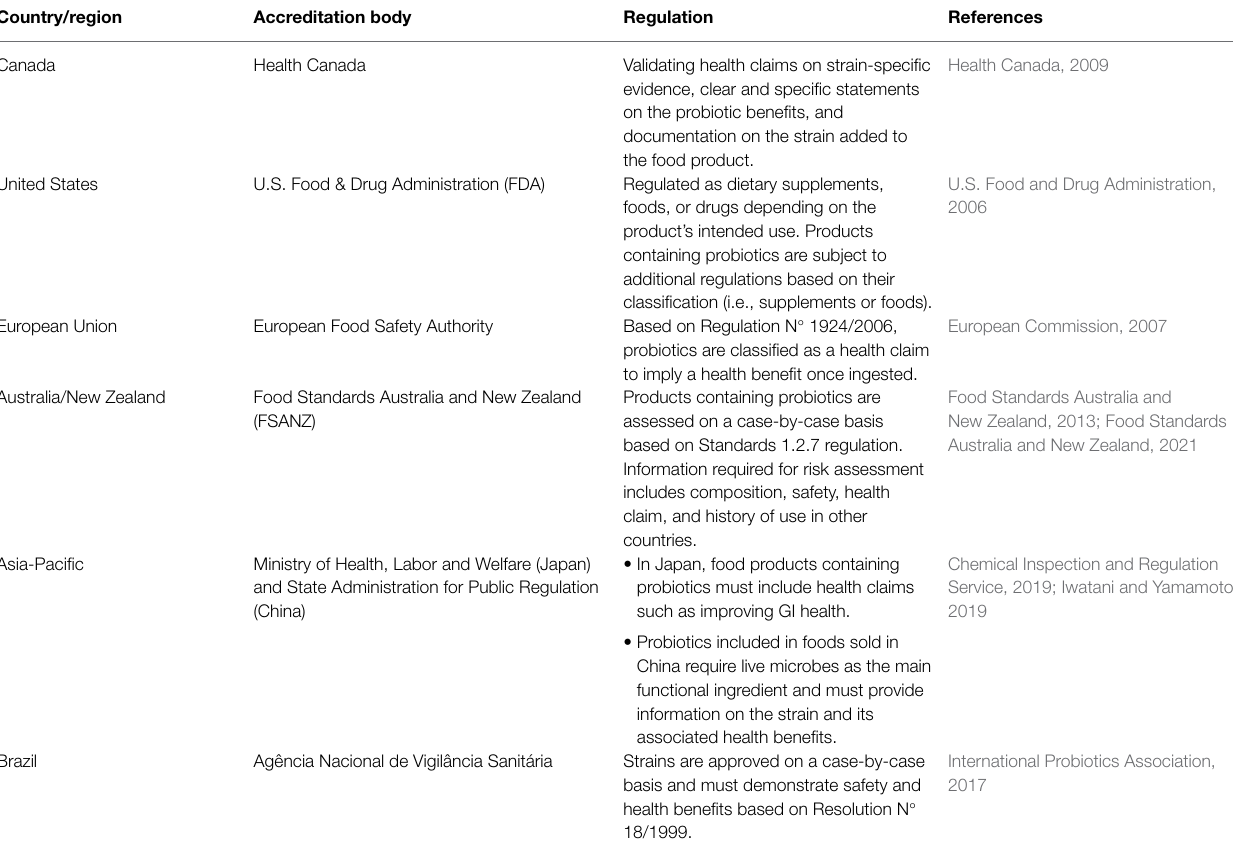
TABLE 4 | Comparison of probiotic regulations between countries and